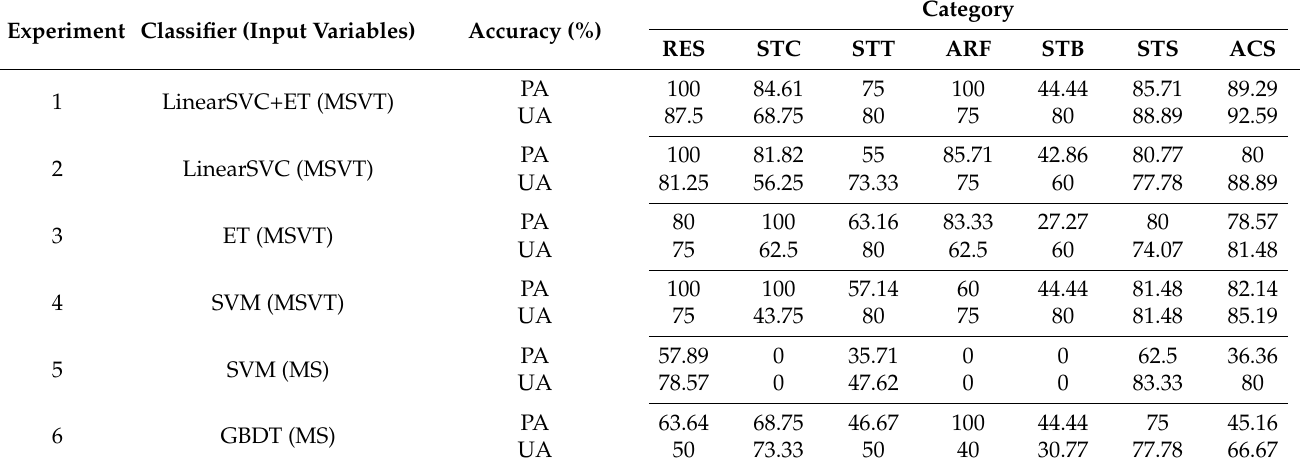
Table 8. PA and UA of the six experiments.